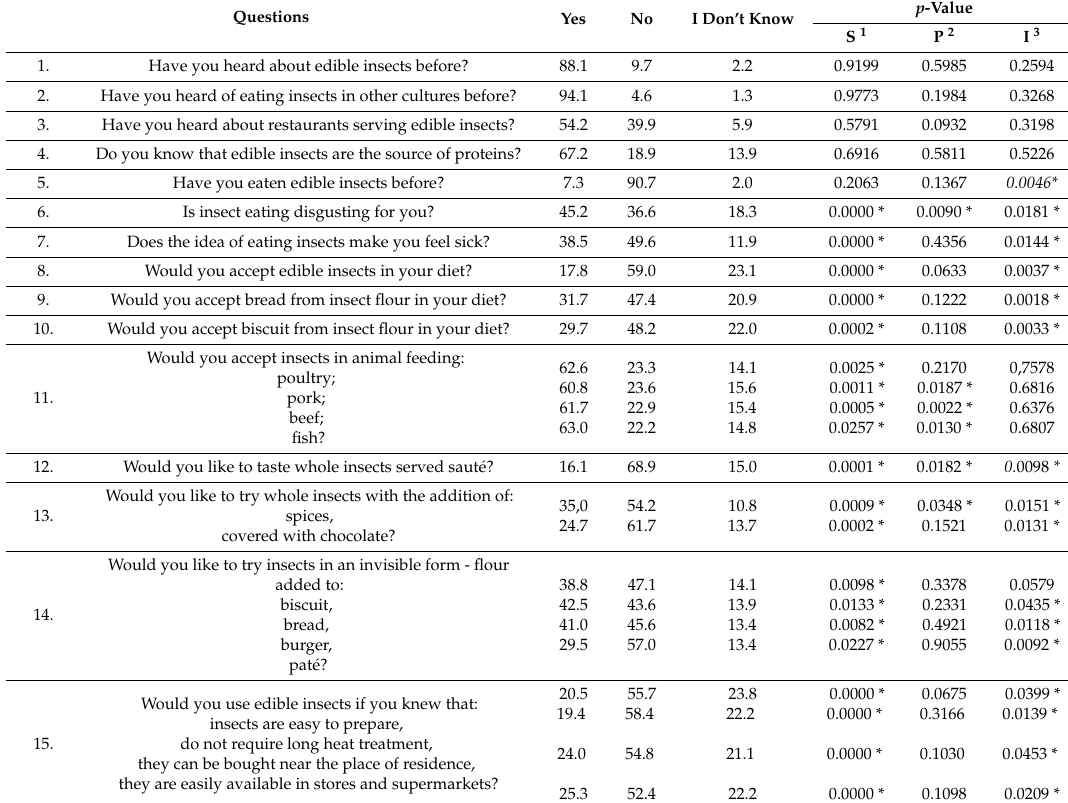
Table 3. Distribution of answers to survey questions and p -value for χ 2